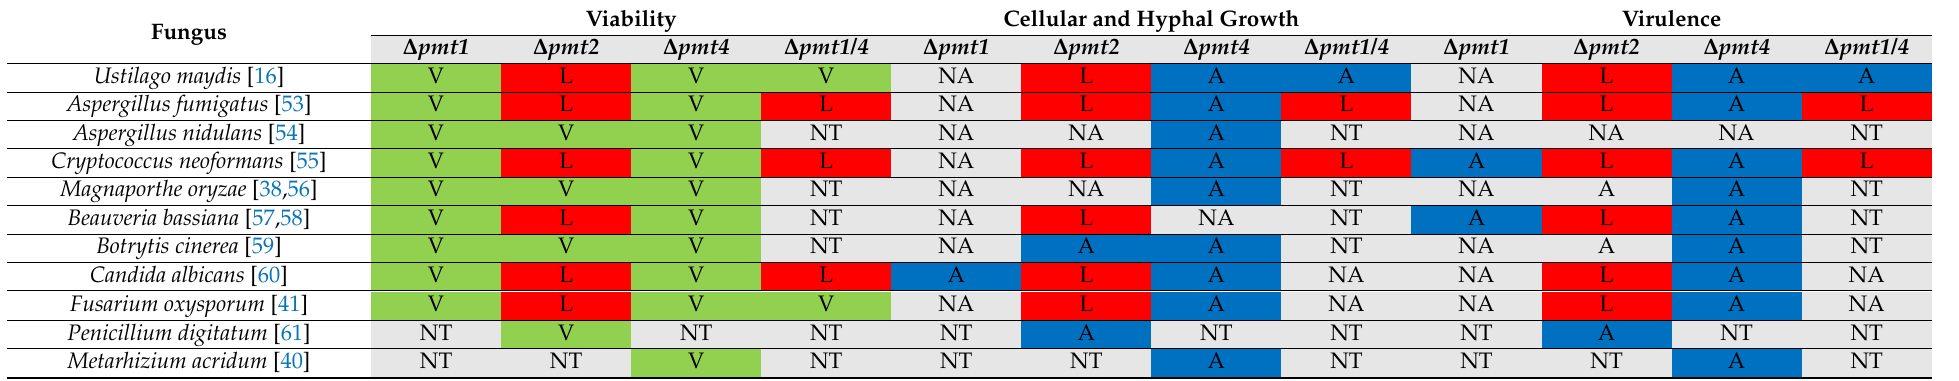
Table 1. Summary of the main phenotypes associated with the loss of Pmts in pathogenic fungi. V, viable; L, lethal; NT, not tested; A, severely affected; NA, not severely